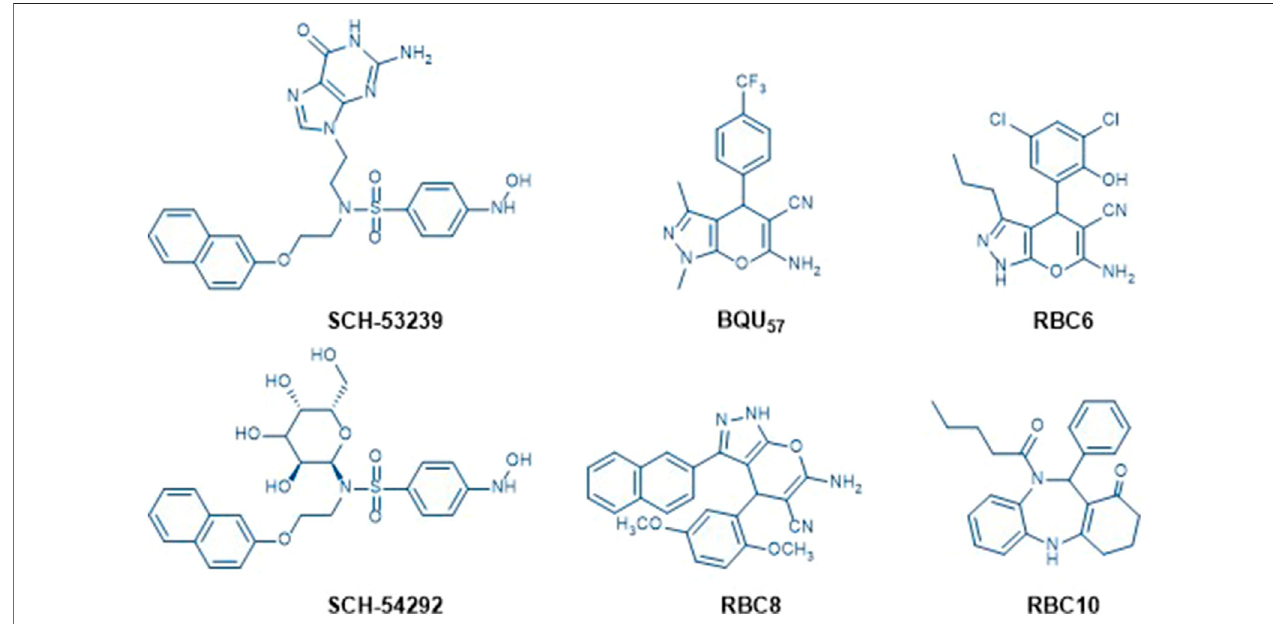
FIGURE 1 | Chemical structures of known Ral inhibitors, including SCH-53239, SCH-54292, BQU57, RBC6, RBC8, and RBC10.